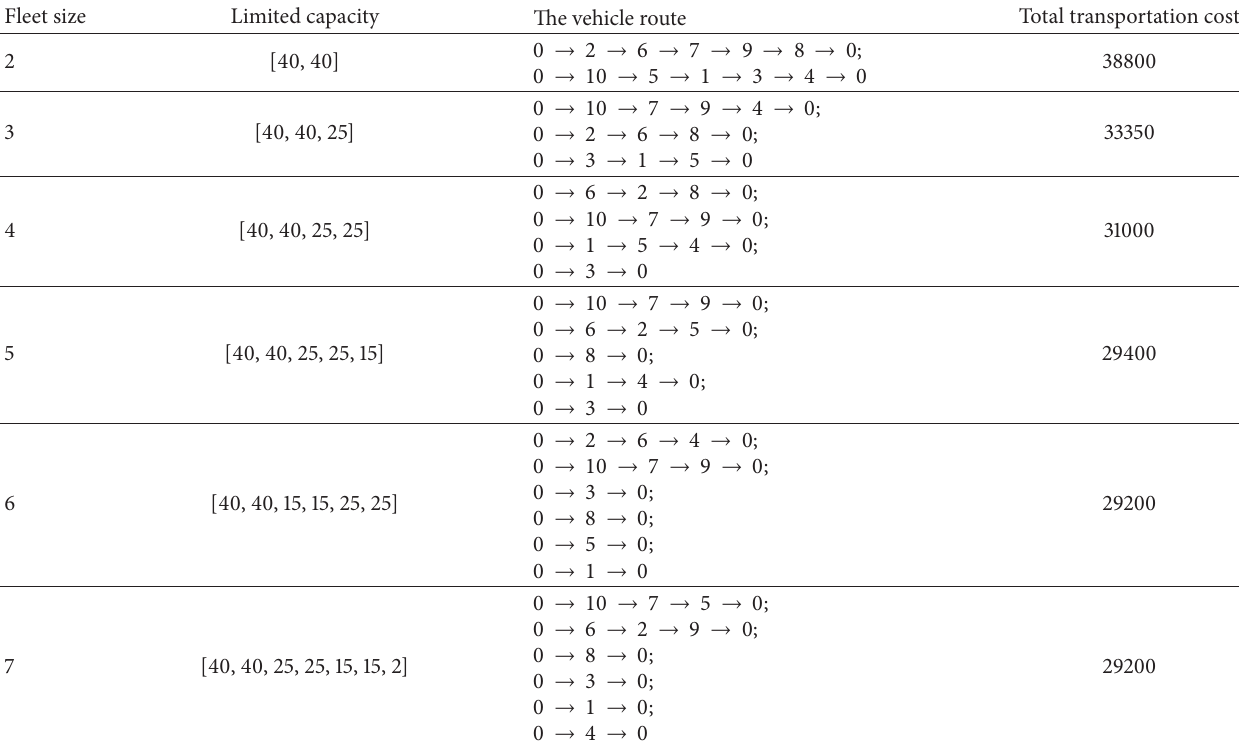
Table 6: The results without time-window